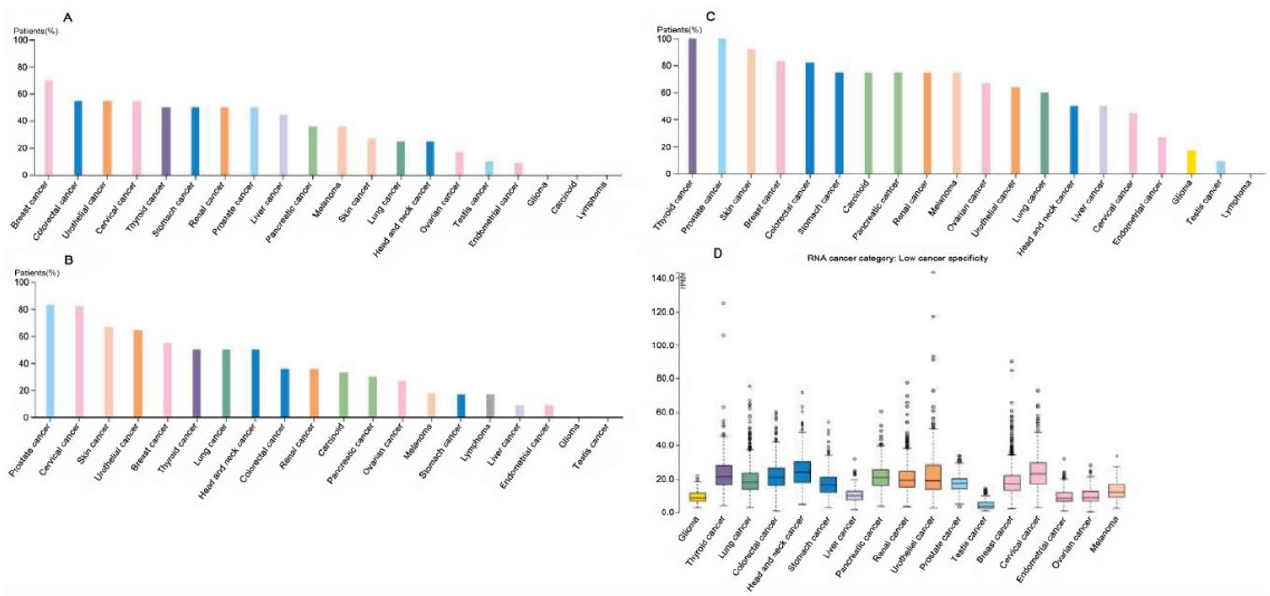
Figure 2. Bodymap indicating CAST expression; red for tumor and green for normal. Statistically significant in GBM, PAAD, STAD, TGCT, UCEC, and UCS.